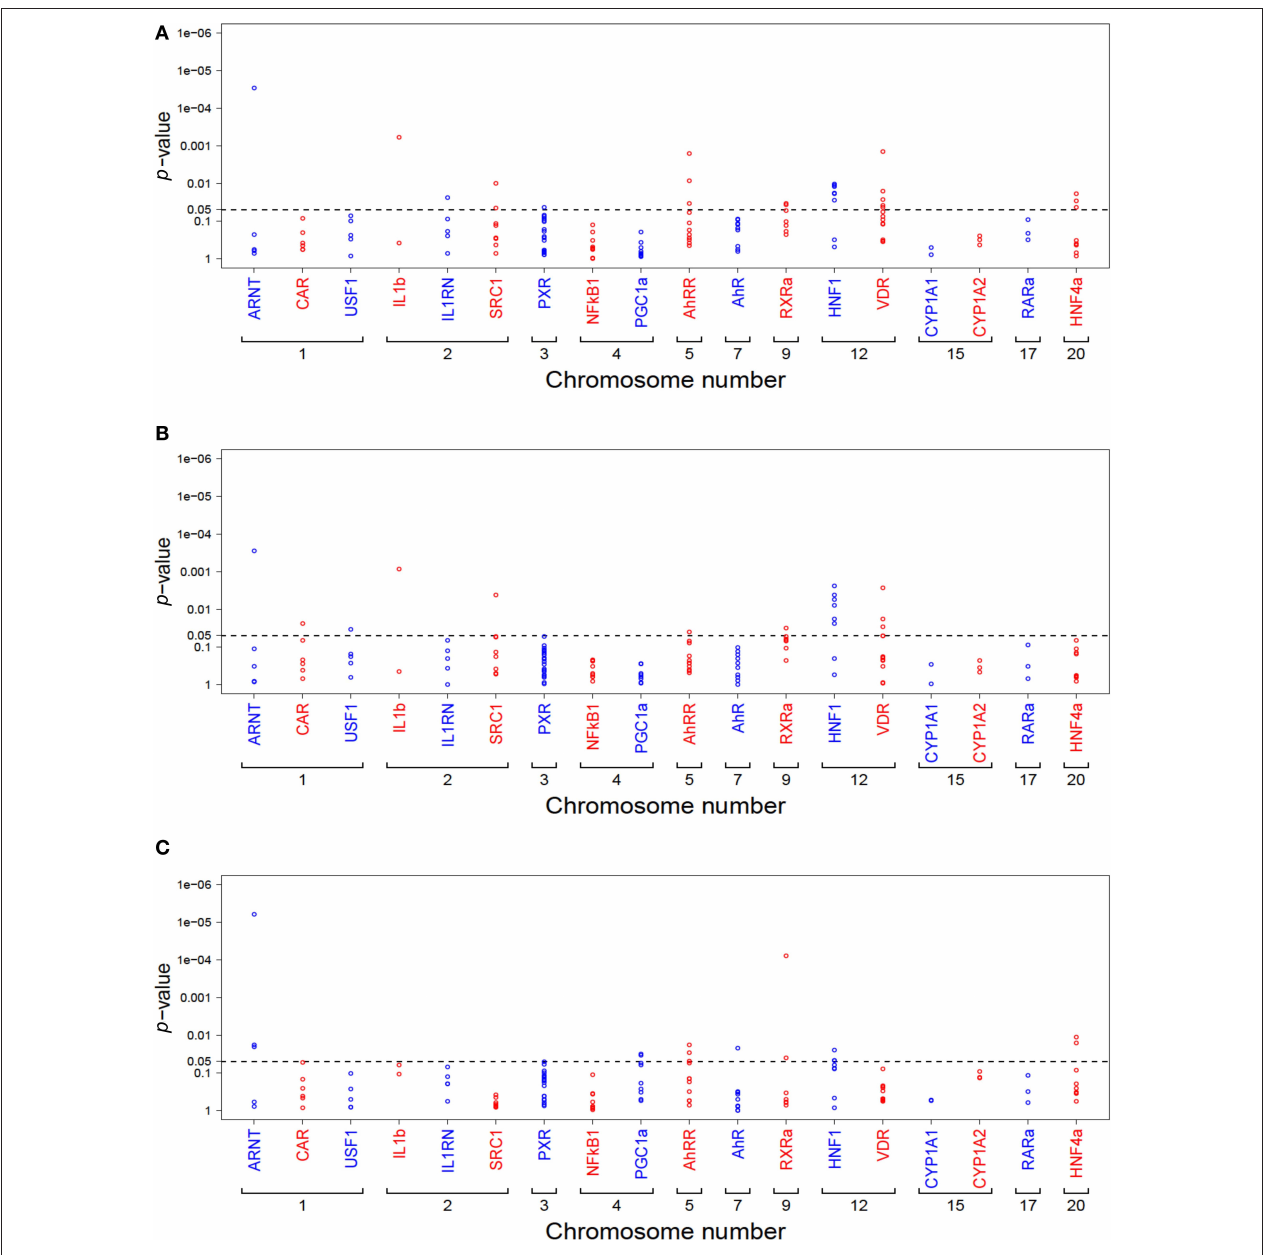
Figure 4 | Summary of univariate analysis of all tested SNPs ( n = 136) in relation to CYP1A2 activity (A), protein (b), and mrNA (C). Each dot represents the minimum p -value from all four genetic models (codominant, dominant, recessive, log-additive). Genes are ordered due to chromosomal location. The dotted line marks the 5% significance level p -values are not adjusted for multiple